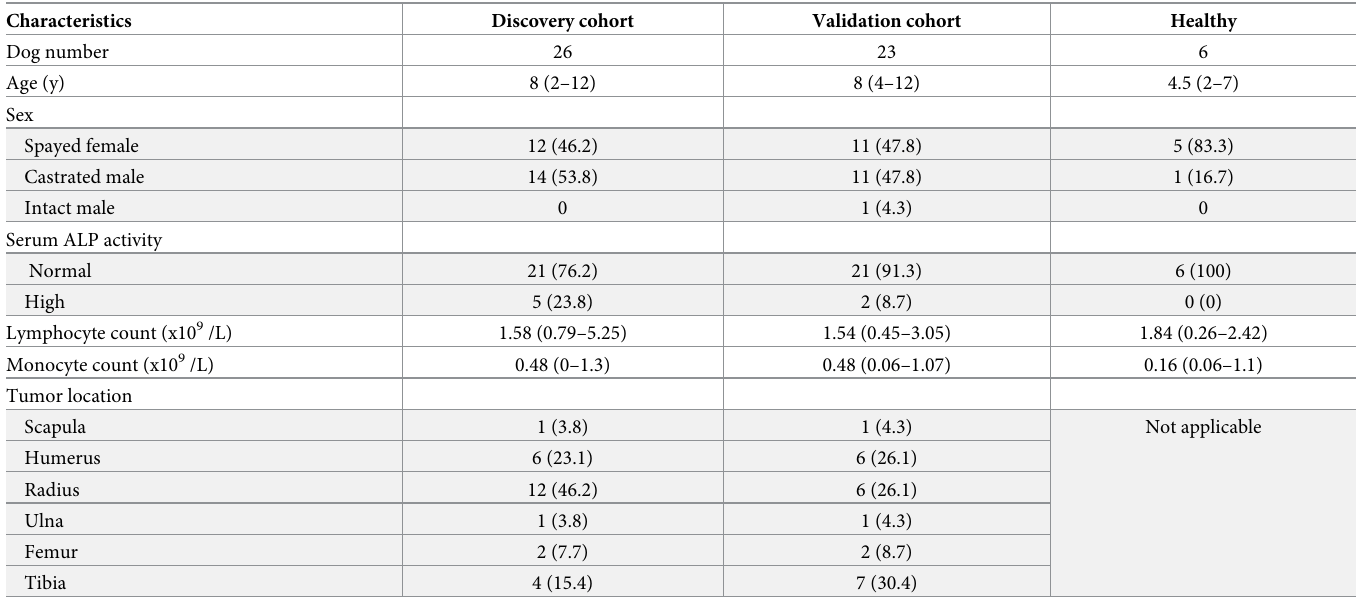
Data are reported as median (range) for age, lymphocyte, and monocyte count, and number (%) of dogs in category for sex, serum ALP activity (relative to reference range), and tumor location.